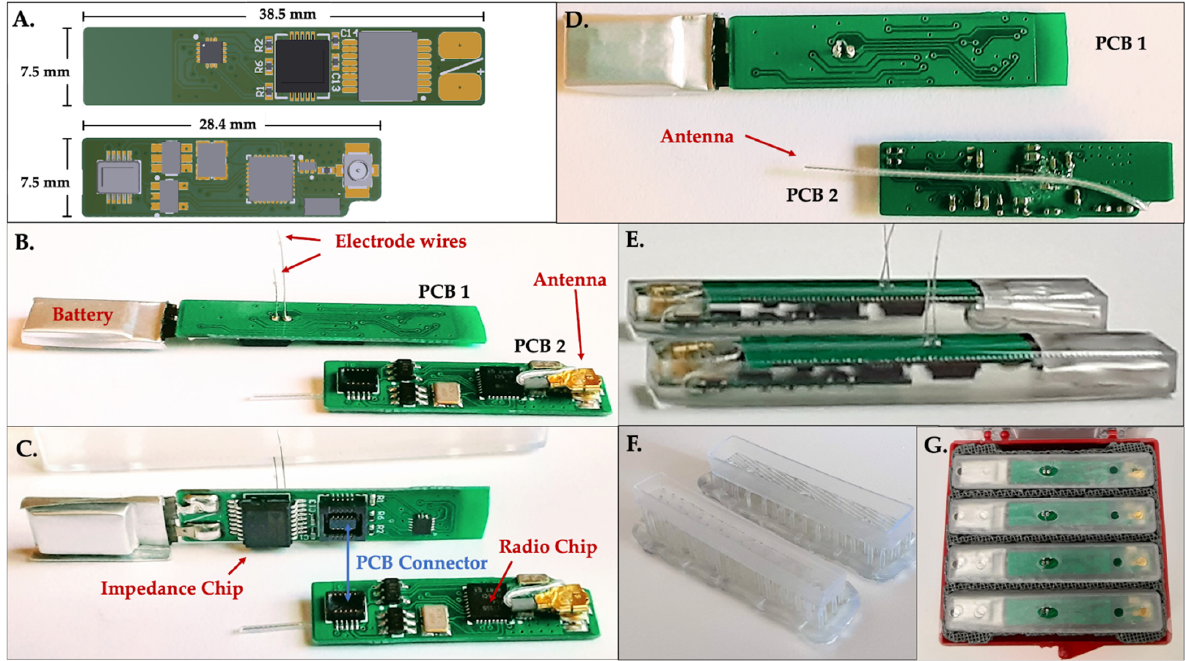
Figure 1. Smart sensor design and accompanying components. ( A ) CAD rendering of component PCBs with dimensions. ( B – D ) Component PCBs and ( E ) assembled sensors encapsulated in resin housing. ( F , G ) Custom 3D printed packaging.